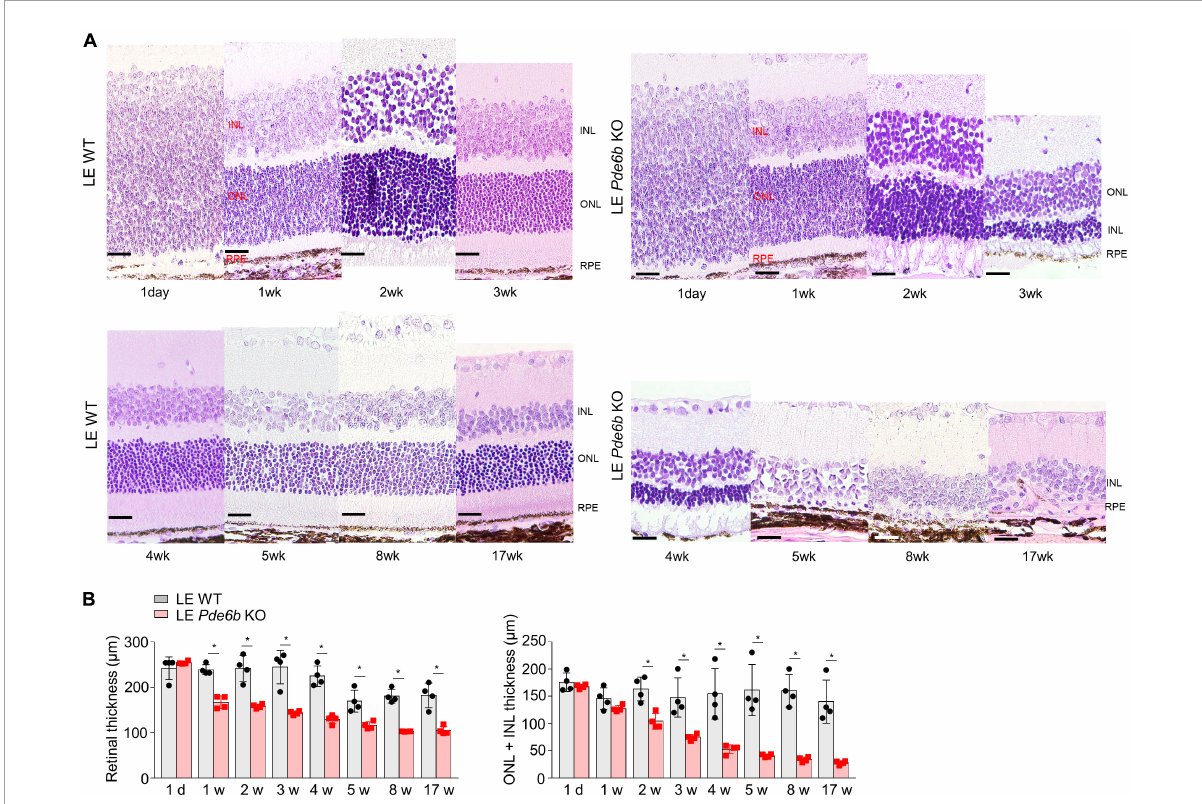
FIGURE4 Histologic analysis of the retinas of wild-type Long–Evans rats and Pde6b -knockout Long–Evans rats. (A) Serial images of the H&E staining of cross-sectioned retinas of wild-type Long–Evans rats (LE WT) and Pde6b -knockout rats (LE Pde6b KO) at each time point over a 17-week period. Compared with LE WT rats, LE Pde6b KO rats showed progressive thinning of the total retinal thickness, especially in the outer nuclear layer. (B) Quantification of retinal thicknesses over 17 weeks. INL, inner nuclear layer; ONL, outer nuclear layer. Scale bars, 20 µ m. * P < 0.05, n = 4 eyes per